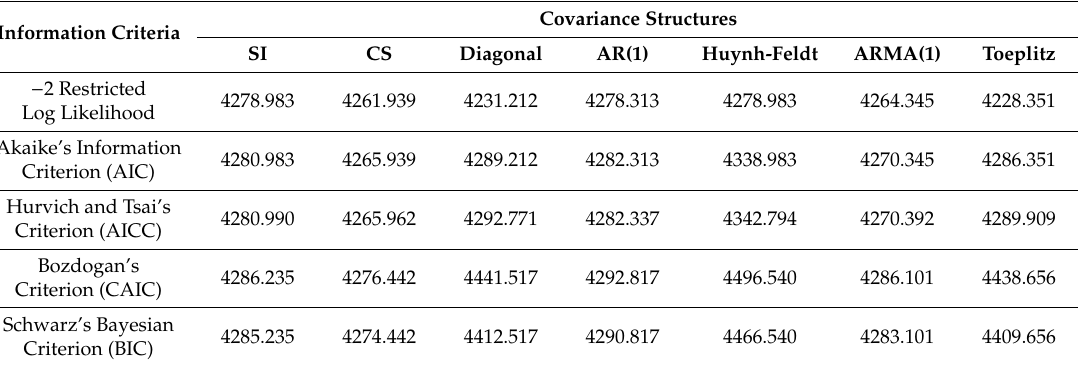
Table 3. Information criteria for di ff erent covariance structures